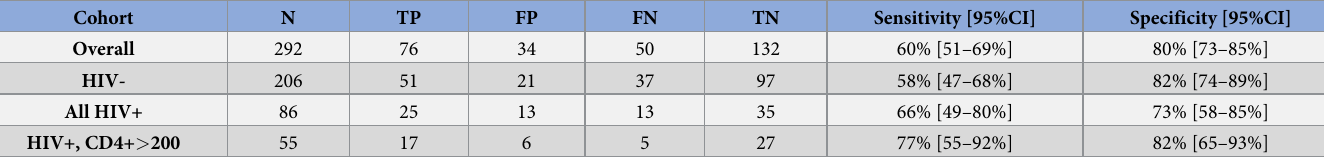
Table 2. Performance of visually read prototype TB LAM LFA vs. microbiological reference standard. Cohort